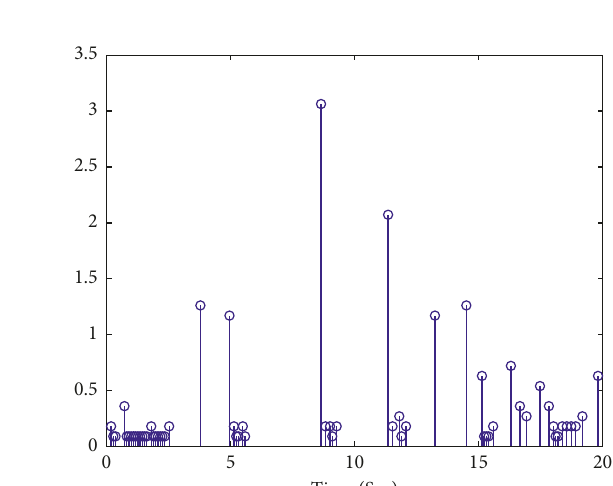
Figure 4: Time interval of each triggered